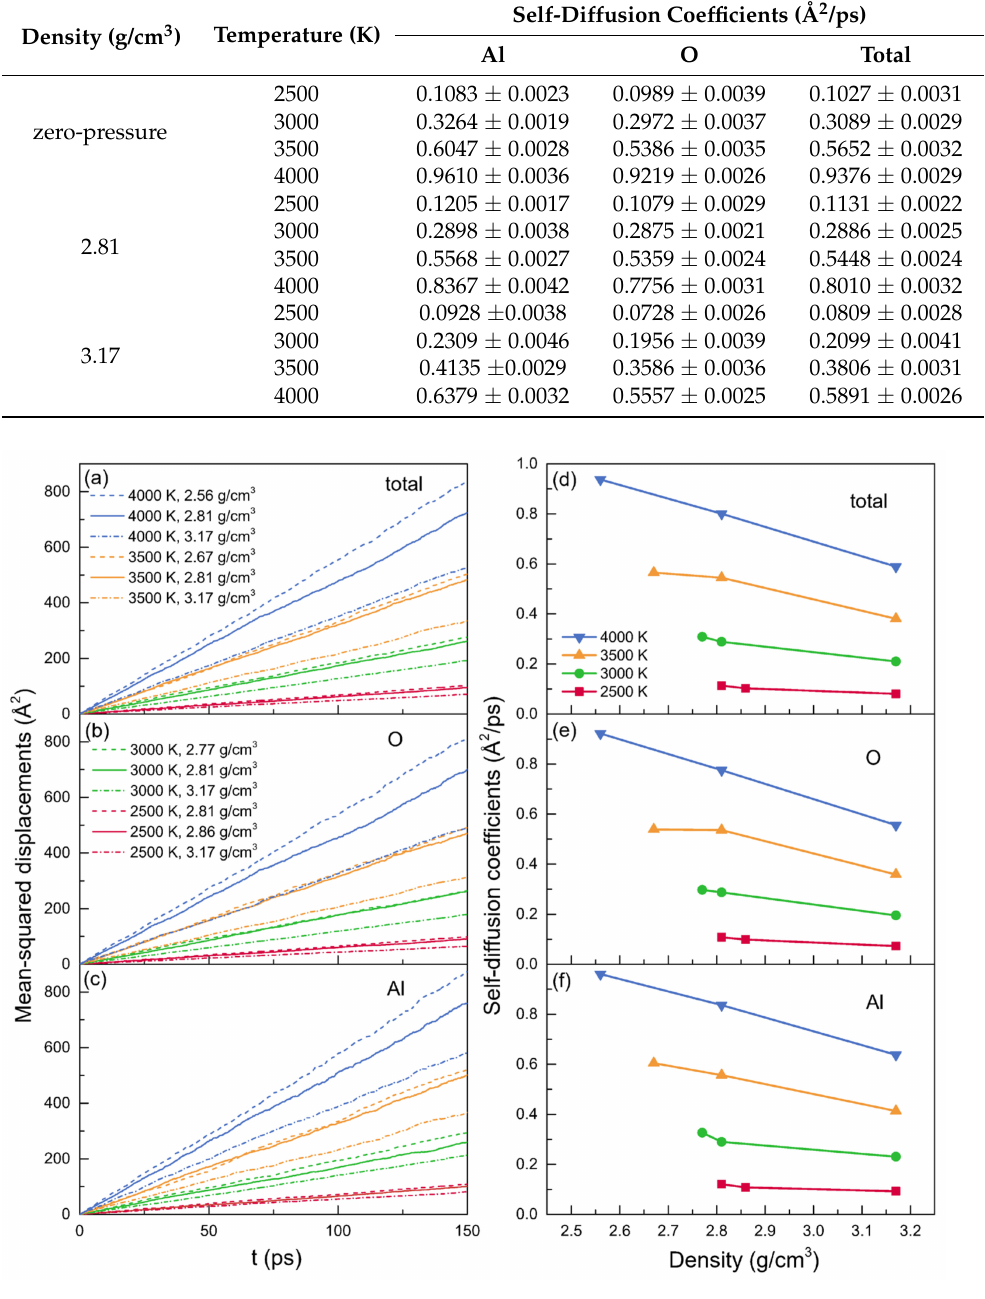
Figure 6. ( a – c ) The mean-squared displacements (MSDs) and ( d – f ) the averaged self-diffusion coefficients ( D ) for liquid alumina at temperatures of 2500 K, 3000 K, 3500 K and 4000 K, with three densities at each